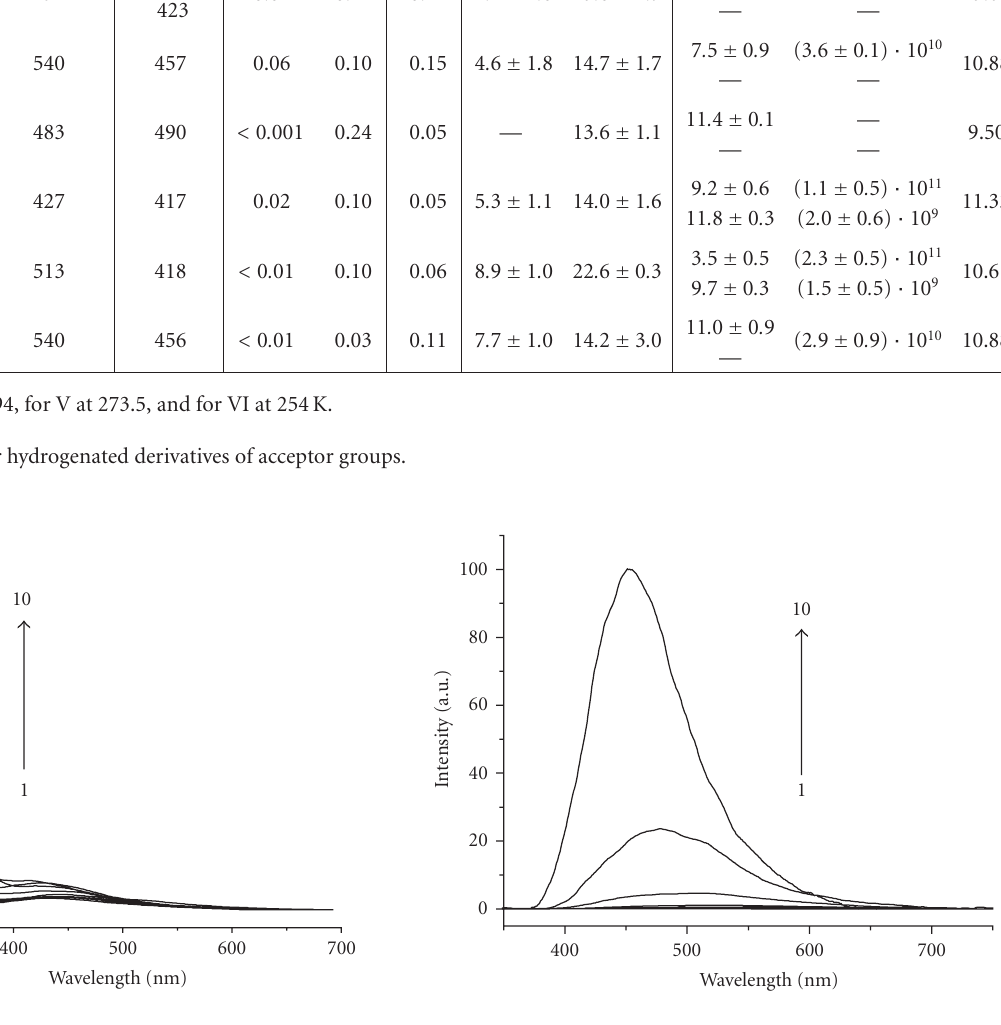
Figure 2: The fluorescence spectra of III in ethanol at di ff erent tem- peratures: 1(296), 2(273), 3(253), 4(232), 5(214), 6(192), 7(175), 8(152), 9(131), and 10(114K). λ exc = 354 nm.